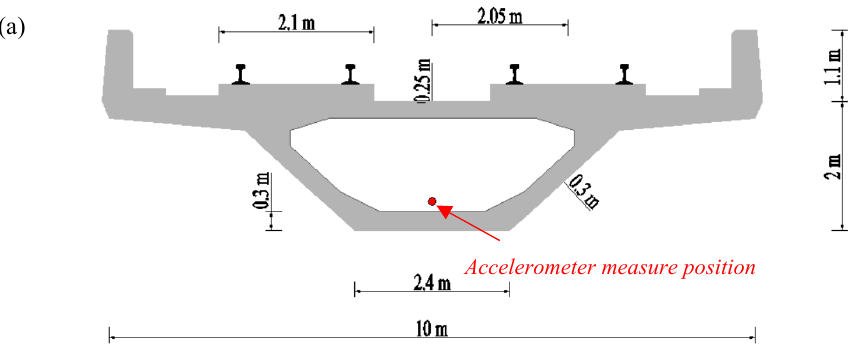
Figure 1. Photo of the selected train and bridge: ( a ) the B-type metro train; ( b ) the continuous, three-span, rigid-frame bridge (42 m + 65 m + 42 m).